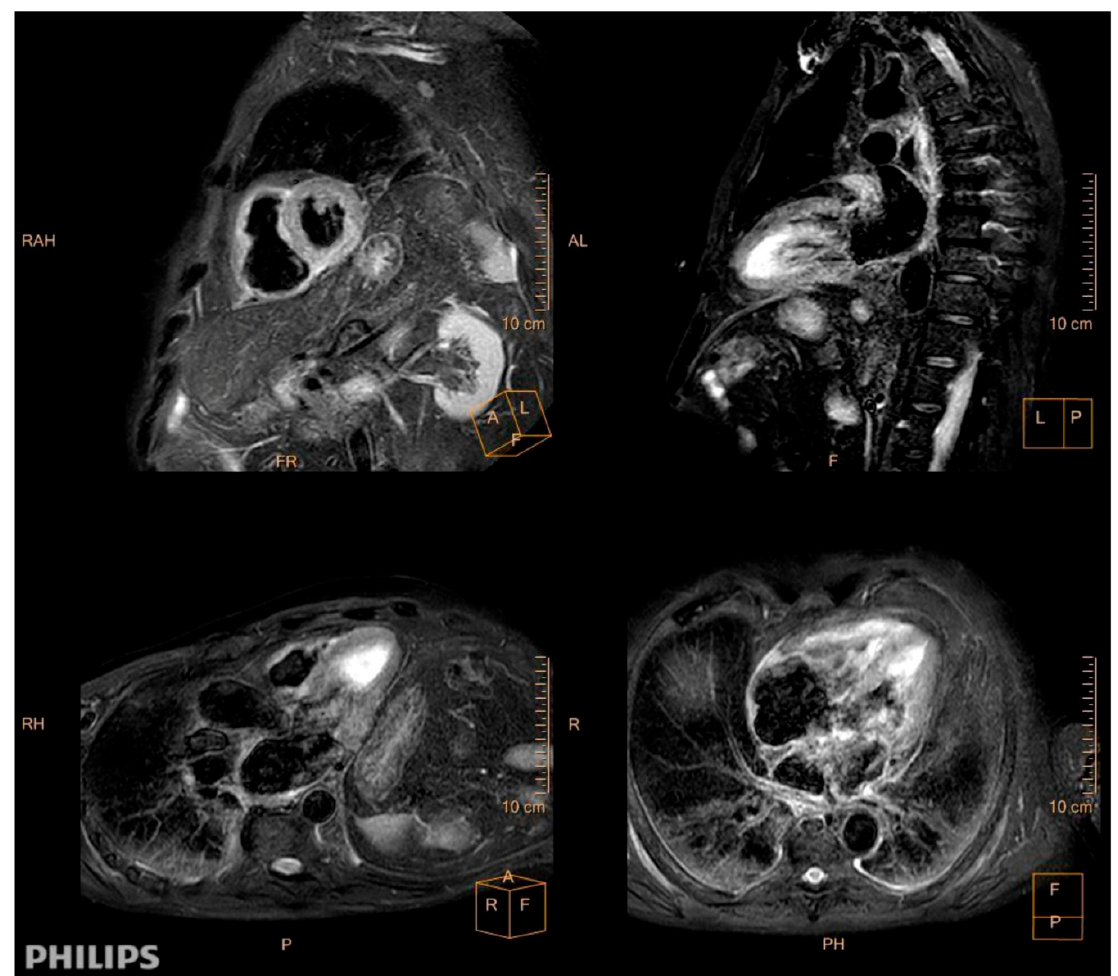
Figure 1. Cardiac magnetic resonance imaging (MRI). Diffuse myocardial edema in